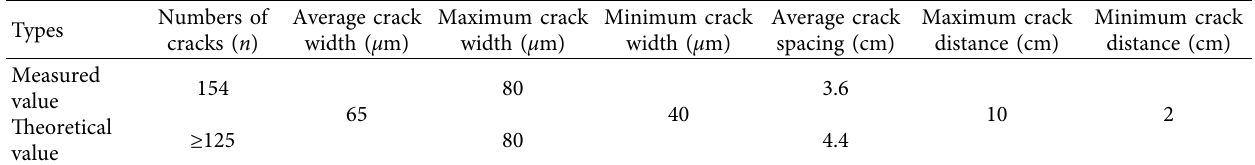
Figure 8: Cracking pattern of the experimental model (unit: cm). (a) Distribution of local cracks in the SHCC slab. (b) SHCC slab crack width Table 5: Comparison of crack width and crack spacing: experimental and theoretical values.